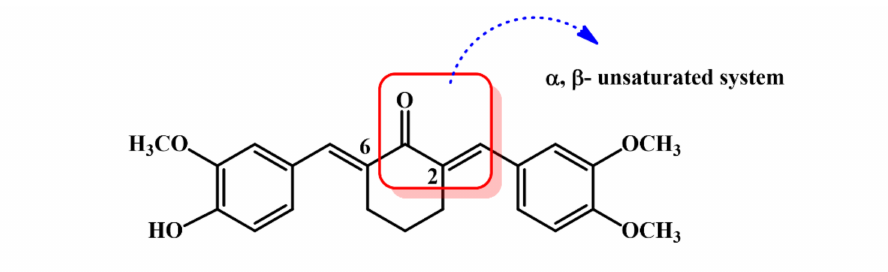
Figure 5. Chemical structure of BHMC